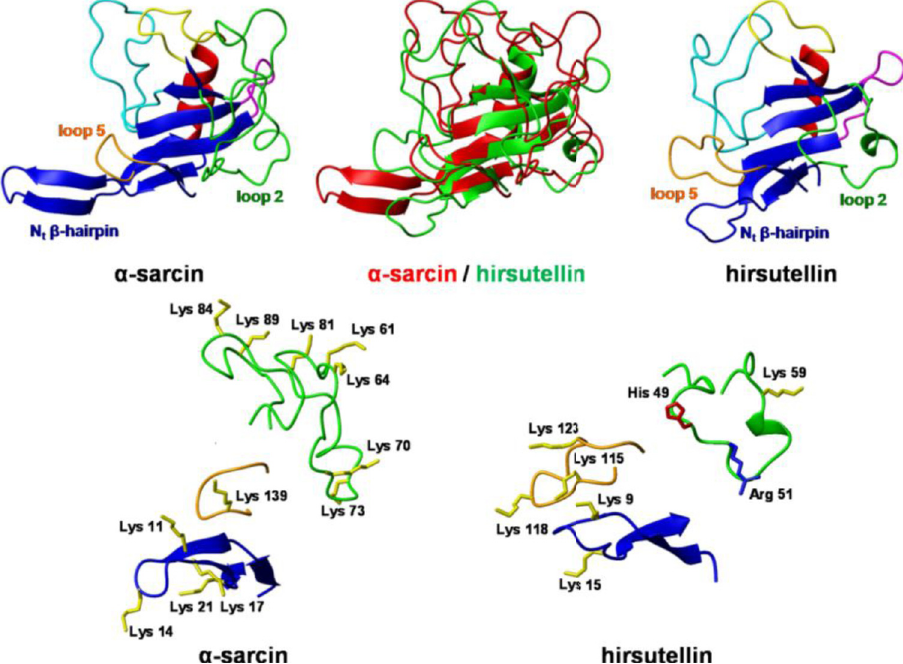
Figure 3. Three-dimensional structures of the ribotoxins (cid:68) -sarcin and hirsutellin A (HtA) Spatial orientation of the N-terminal (cid:69) -hairpin and loops 2 and 5 in HtA and (cid:68) -sarcin. Positively charged residues are depicted. Color code is the same as in Figure 1. The diagrams were generated using MOLMOL